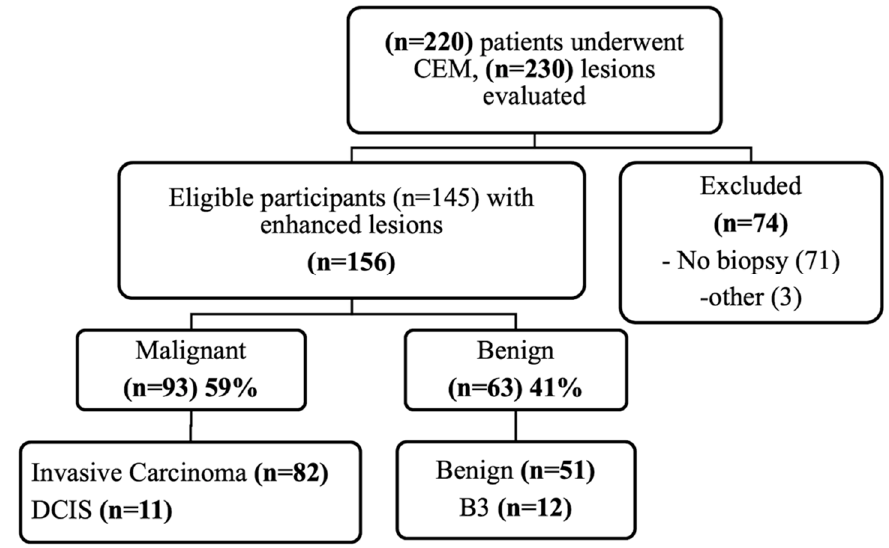
Figure 1. Flowchart describing the patient population. CEM: contrast-enhanced mammography; DCIS: ductal carcinoma in situ; B3: lesions of uncertain malignant potential. Table 1. Final histological characteristics of biopsied lesions.